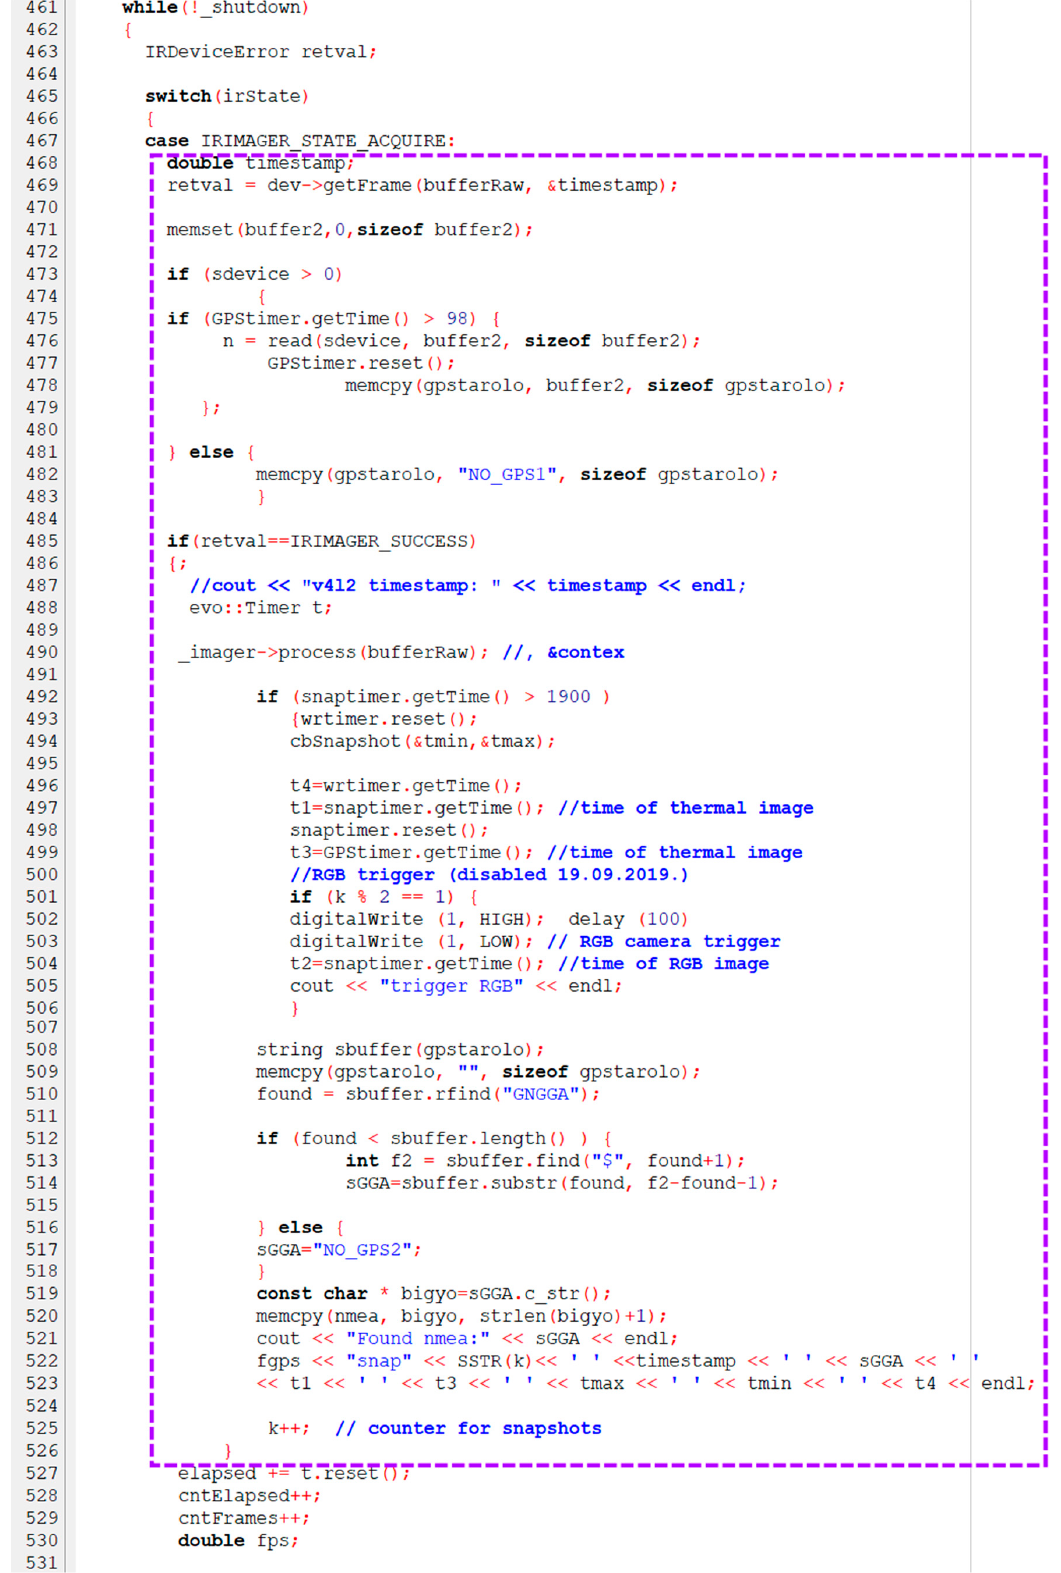
Figure A3. Controlling script of the thermal imaging system, part 3: Reading of the GNSS information from the serial port, initiating the thermal snapshot, triggering the RGB camera, and writing the necessary information into a text file The purple dashed frame highlights the inserted parts.